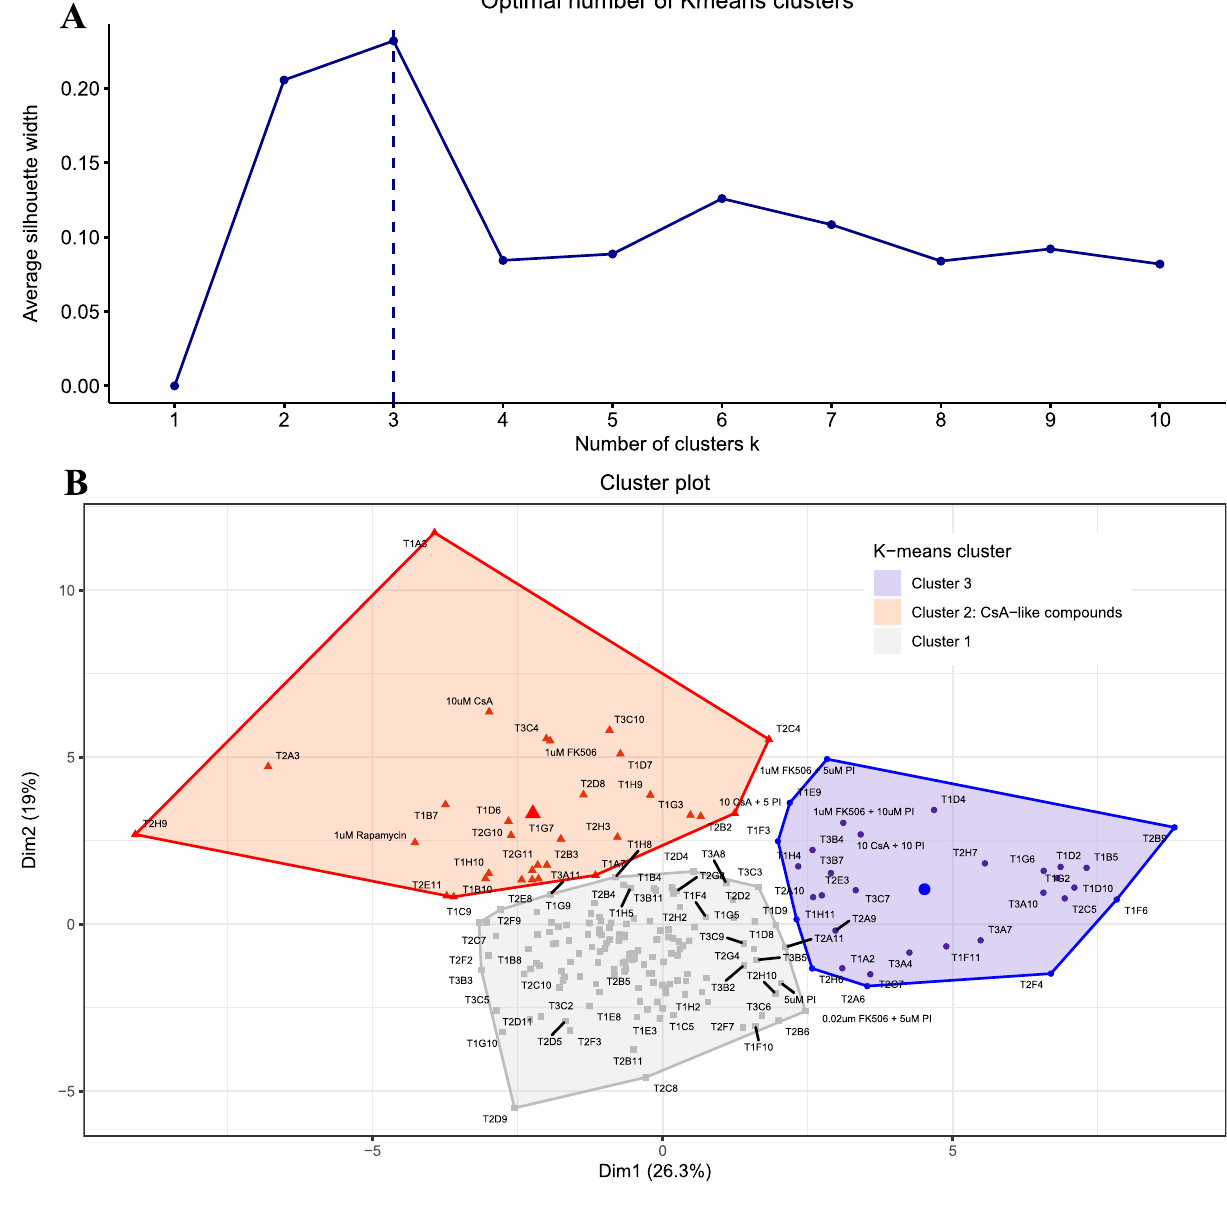
Figure 4. K-means clustering: using the average silhouette width method, we determined that the optimal number of K-means clusters for our dataset was 3 ( A ). We then plotted each of our initial data points on Dim1 (X-axis) and Dim 2 (Y-axis) with the optimal number of clusters (Km = 3) for our dataset. K-means clustering showed in three distinct clusters on the PCA axis ( B